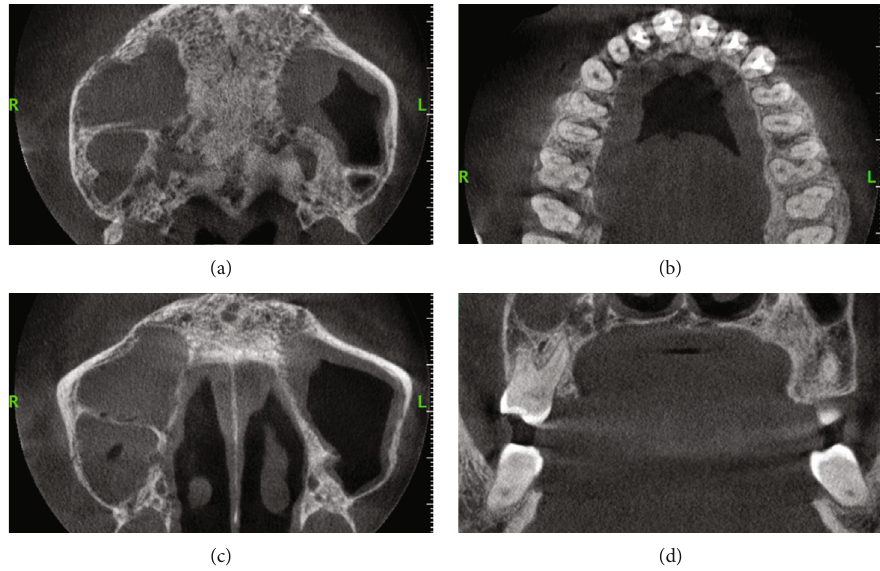
Figure 4: CBCT of case 1: (a – c) axial views; (d) cross-sectional view. (a) Osteolytic change in the posterior area. (b) Radiopaque obturating material in maxillary anterior teeth with resorption of alveolar process. (c) Haziness in the maxillary sinus on the right side. (d) Osteolytic changes on the palatal alveolar region on the maxillary 1 st molar.